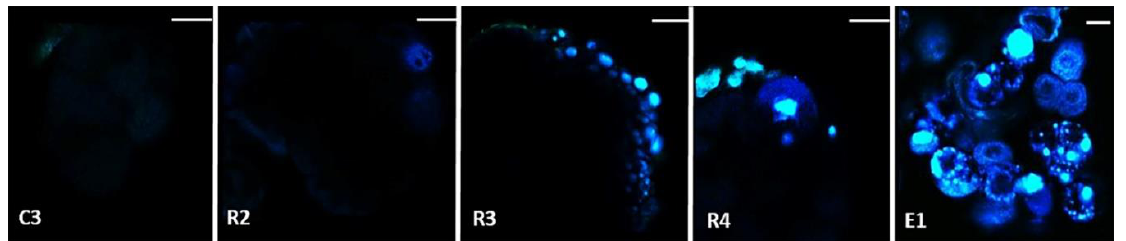
Figure 4. Chlorogenic acid localization in embryogenic cell clusters ( C3 ) and during embryo redifferentiation after 1 day ( R2 ), 3 days ( R3 ), 10 days ( R4 ) and 3 weeks ( E1 ) in redifferentiation medium after cell density reduction. Protuberance of newly generated embryos emerge after 10 days in redifferentiation medium and globular-shaped embryos are obtained after 3 weeks. For chlorogenic acid localization, fresh samples were mounted on a glass slide in a drop of water and observed using a Zeiss LSM880 multiphoton microscope, equipped with a Chameleon Ultra II laser. Excitation